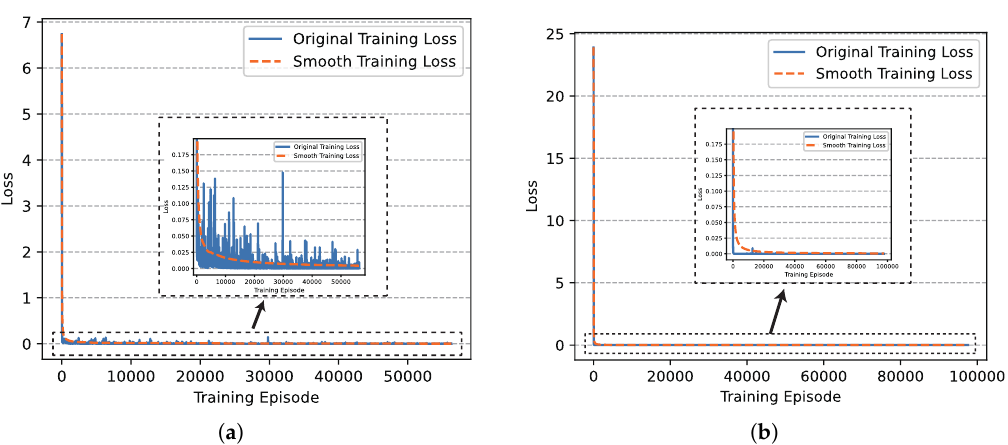
Figure 14. The comparison of critic networks’ training loss involved in UER-DDPG and PER-DDPG over training episode. ( a ) The training loss of critic network of UER-DDPG. ( b ) The training loss of critic network of PER-DDPG.